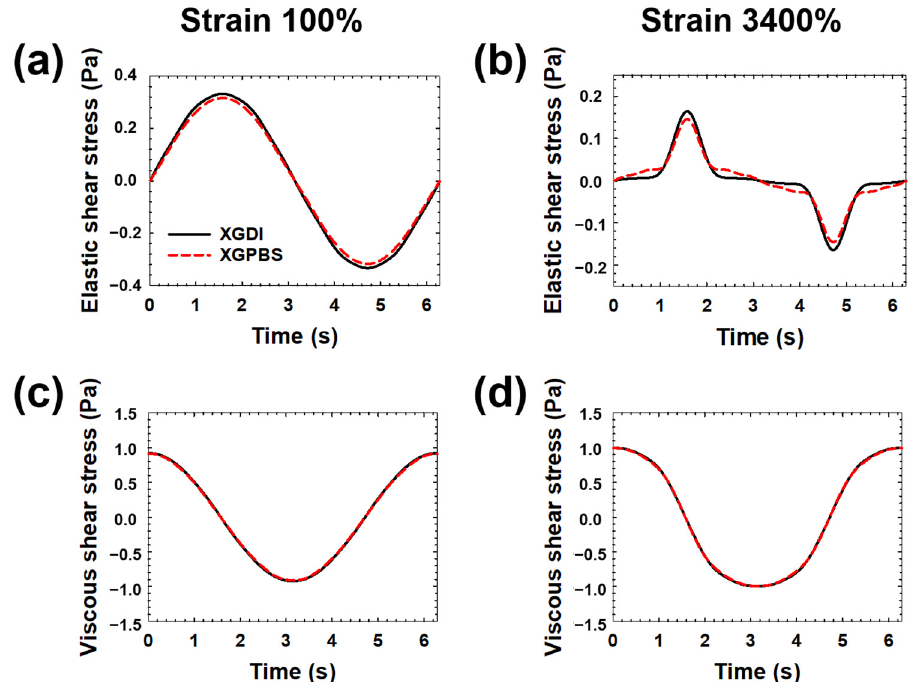
Figure 5. Large-amplitude oscillatory shear test data for the xanthan gum solutions (XGDI and XGPBS) Figure 5. Large ‐ amplitude oscillatory shear test data for the xanthan gum solutions (XGDI and at the fixed frequency of 1 rad / s and 20 ◦ C. The stress measured at strain = 100% (left column) and XGPBS) at the fixed frequency of 1 rad/s and 20 °C. The stress measured at strain = 100% (left column) 3400% (right column) was decomposed into the elastic ( a , b ) and viscous ( c , d ) strain as previously and 3400% (right column) was decomposed into the elastic (( a ) and ( b )) and viscous (( c ) and ( d )) strain described as previously described [32].